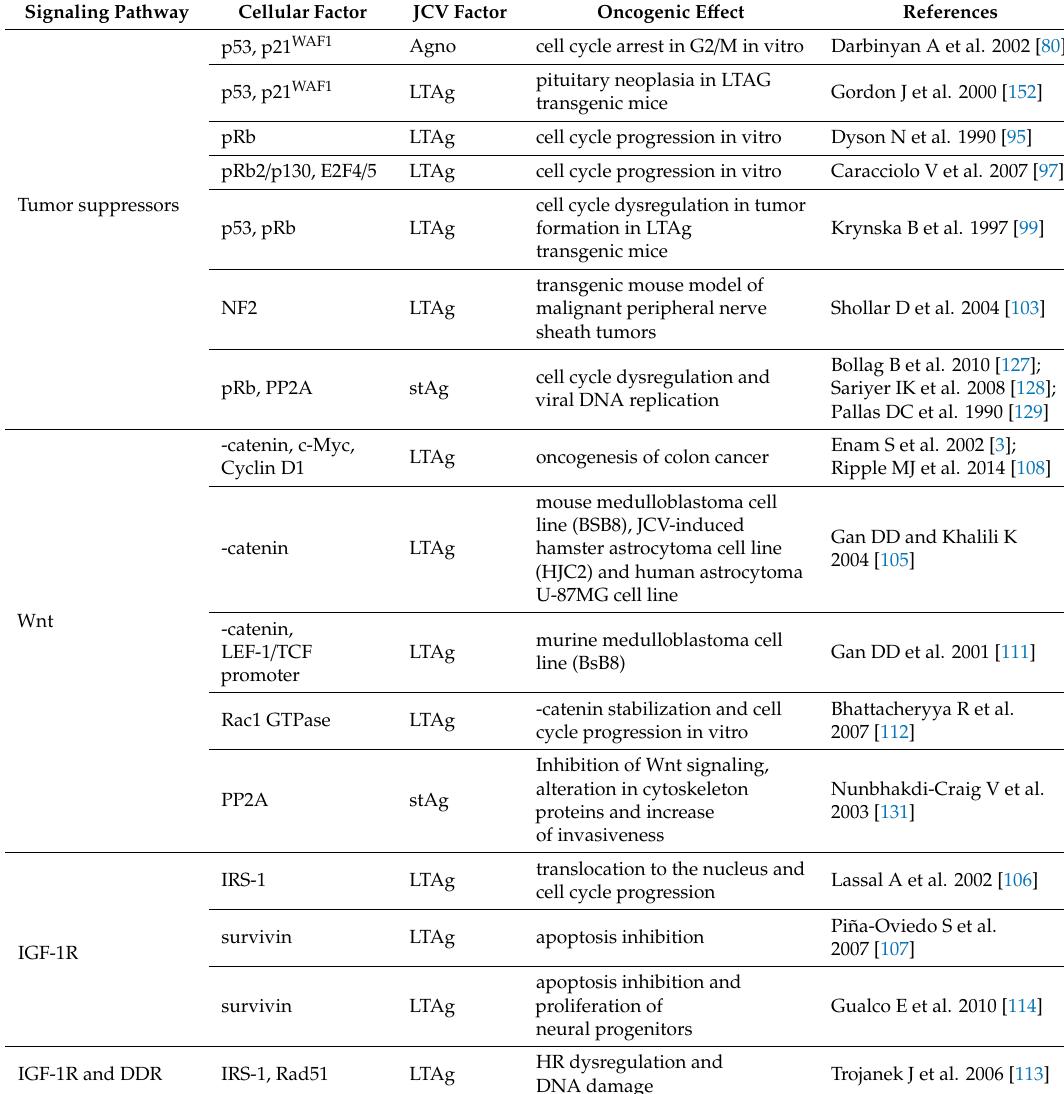
Table 1. JCV-related Oncogenic